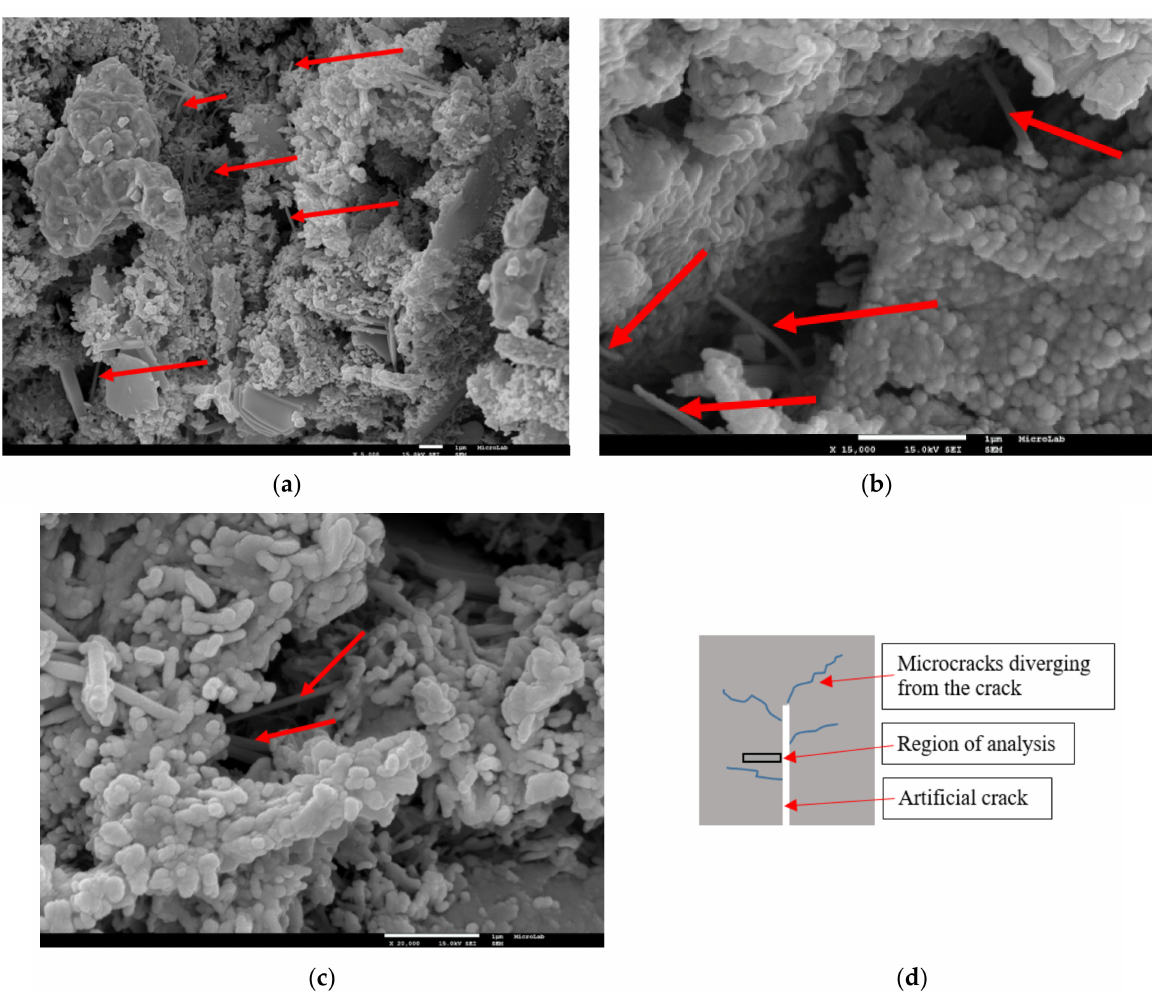
Figure 8. ( a – c ) SEM analysis of CNTRC with artificial cracking (arrows indicate CNT tips or bridging). ( d ) scheme of concrete region analyzed in SEM